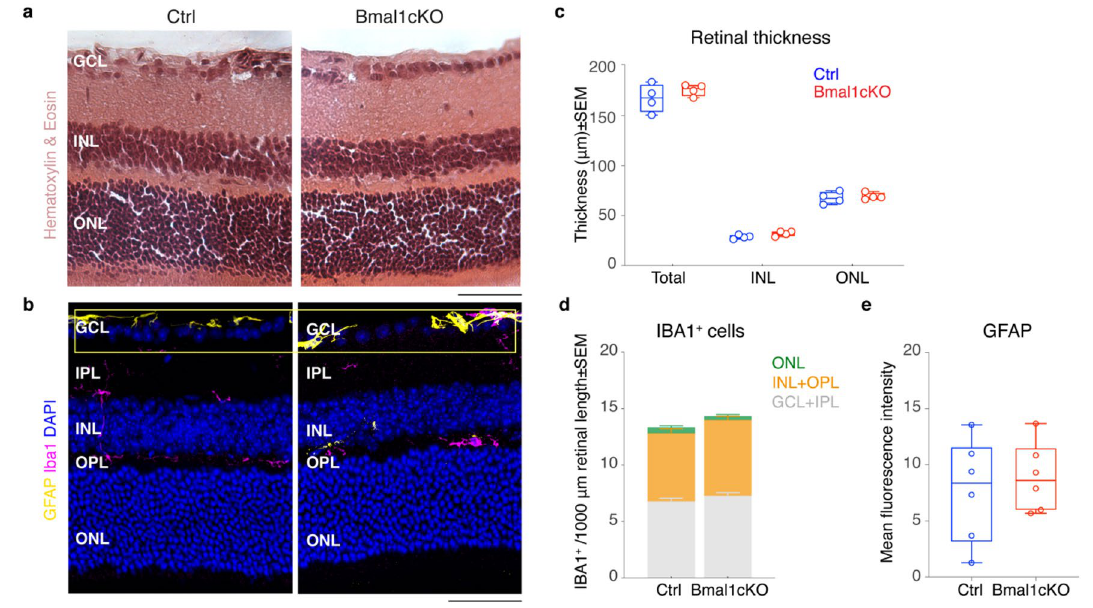
Figure 2. GLAST + cells specific deletion of Bmal1 does not induce changes in retinal morphological or glial cell reactivity. (a) Representative transverse retinal sections from Ctrl and Bmal1 cKO stained with Hematoxylin&Eosin to show the cellular and extracellular morphology. (b) Fluorescence images of retinal sections stained with DAPI (blue) to reveal cell nuclei. Ctrl and Bmal1 cKO retinal sections do not show any apparent difference in neural architecture. IBA1 + cells (pink) are localized in the INL, GCL, and plexiform layers. Any noticeable structural changes in the microglial cells are detectable. GFAP immunoreactivity (yellow) is confined in the astrocytic layer in both conditions (yellow box), indicating the innermost retinal layer astrocyte population. Not detected reactivity of Müller cells. (c) Quantitative comparison of the total retina, INL, and ONL thickness. No statistically significant differences were detected between genotypes. n = 4/4, P > 0.05 vs. Ctrl, Student’s t -test. (d) Quantitative analysis of the number of IBA1 + cells in each layer per 1000 μm segment of retina. No statistically significant differences were detected between genotypes. n = 8/8, P > 0.05 vs. Ctrl, Student’s t -test. (e) Graphs showing GFAP immunoreactivity in Ctrl and Bmal1 cKO per 15e + 3 μm 2 , including the inner and outer retina. No statistically significant differences were detected between genotypes. n = 6/6, P > 0.05 vs. Ctrl, Student’s t -test. ONL outer nuclear layer, INL inner nuclear layer, GCL ganglion cell layer, OPL outer plexiform layer, IPL inner plexiform layer, GFAP glial fibrillary acidic protein, IBA1 ionized calcium-binding adapter molecule 1. Data are shown as mean ± SEM. Scale bar, 50